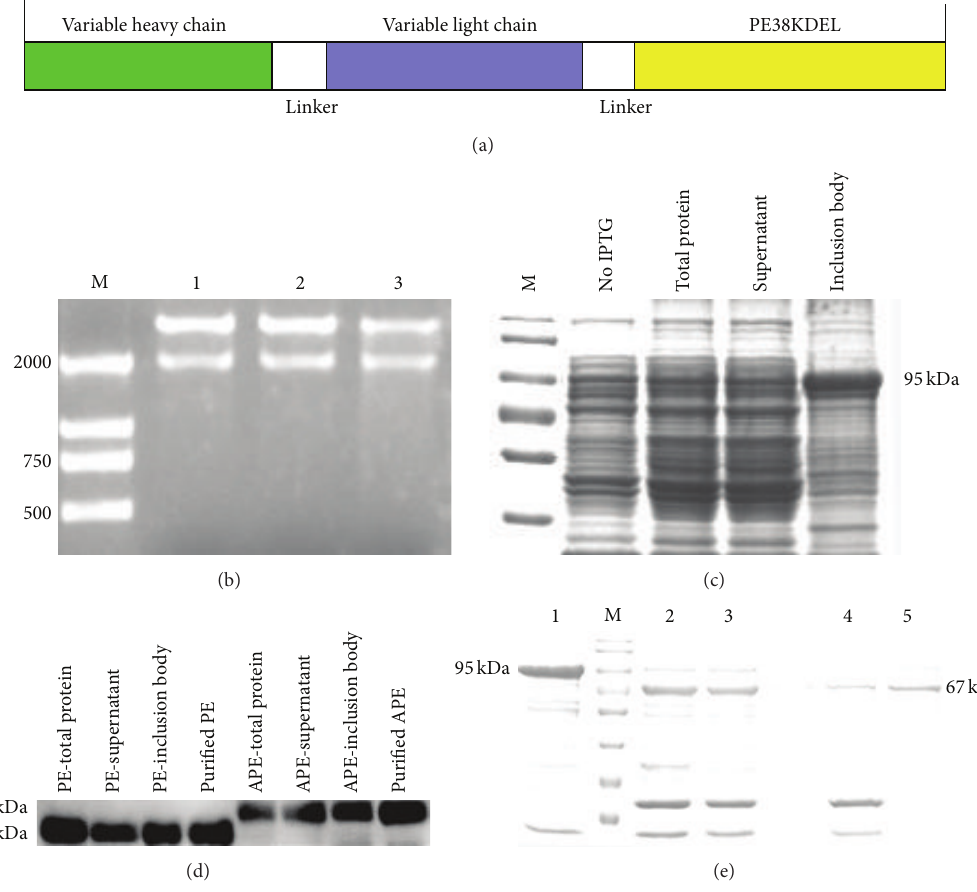
Figure 2: Construction, expression, and purification of immunotoxin. (a) Schematic representation of immunotoxin. (b) Restriction enzyme analysis of the expression plasmid (pGEX-4T1-scFv2A9-PE). Plasmids (lanes: 1–3) were digested with BamH-I and Xhol-I, and the 2,000 bp fragment was the recombinant immunotoxin. Lane: (M) LD2000 DNA ladder. (c) SDS-PAGE of recombinant protein. Protein from noninduced cells, IPTG induced cells, and supernatant and inclusion bodies were separated on 10% agarose gel and stained with Coomassie Brilliant Blue. Lane: (M) protein marker. (d) The recombinant protein was tested via Western blot. APE represents the immunotoxin; PE represents the empty control (pGEX-4T1-PE). (e) The purified recombinant protein was digested with thrombin. After removing the GST tag and thrombin, the immunotoxin was confirmed to be 67 kDa. Lanes: (1) purified APE protein; (M) protein marker; (2) APE after digestion with thrombin; (3) APE after digestion without thrombin; (4) APE without thrombin and GST protein; and (5) purified APE without the GST